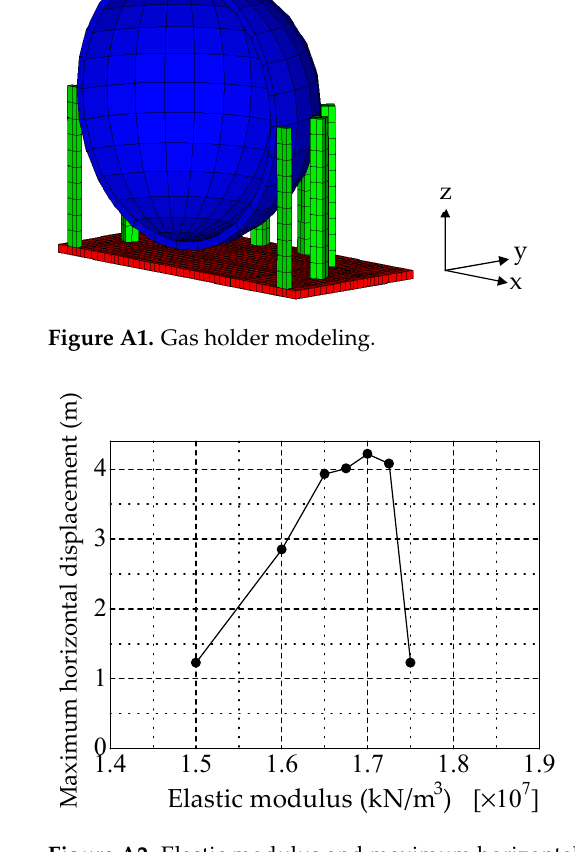
Figure A2. Elastic modulus and maximum horizontal displacement.